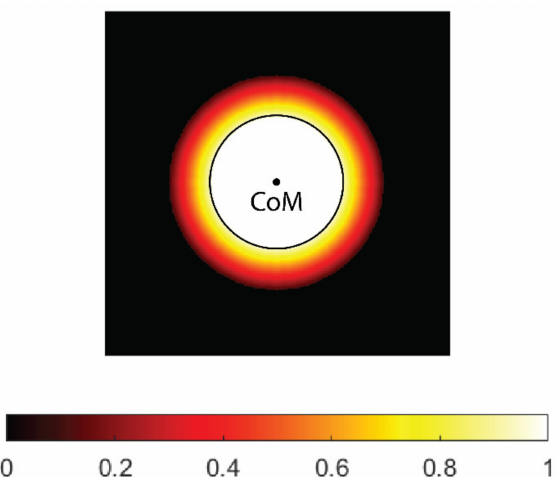
Figure 3. A weighting map of the clinical target volume (CTV). The contour (black) and center of mass (CoM) of the tumor gross volume (GTV, black circle) are shown. The weight uniformly decreases with distance from tumor border and reaches zero on the outer border of the